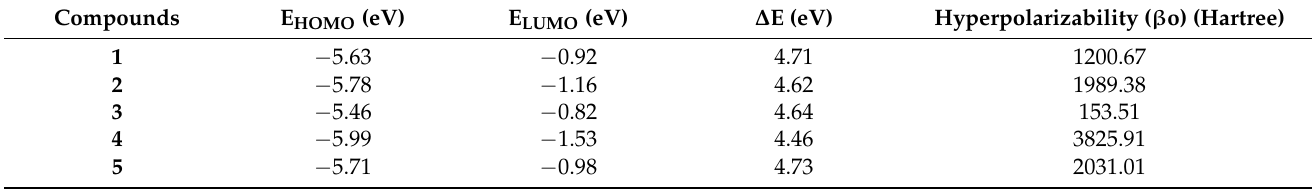
Table 2. Energies of HOMO-LUMO, HOMO-LUMO gap ( ∆ E) and hyperpolarizability values. The unit of β o is